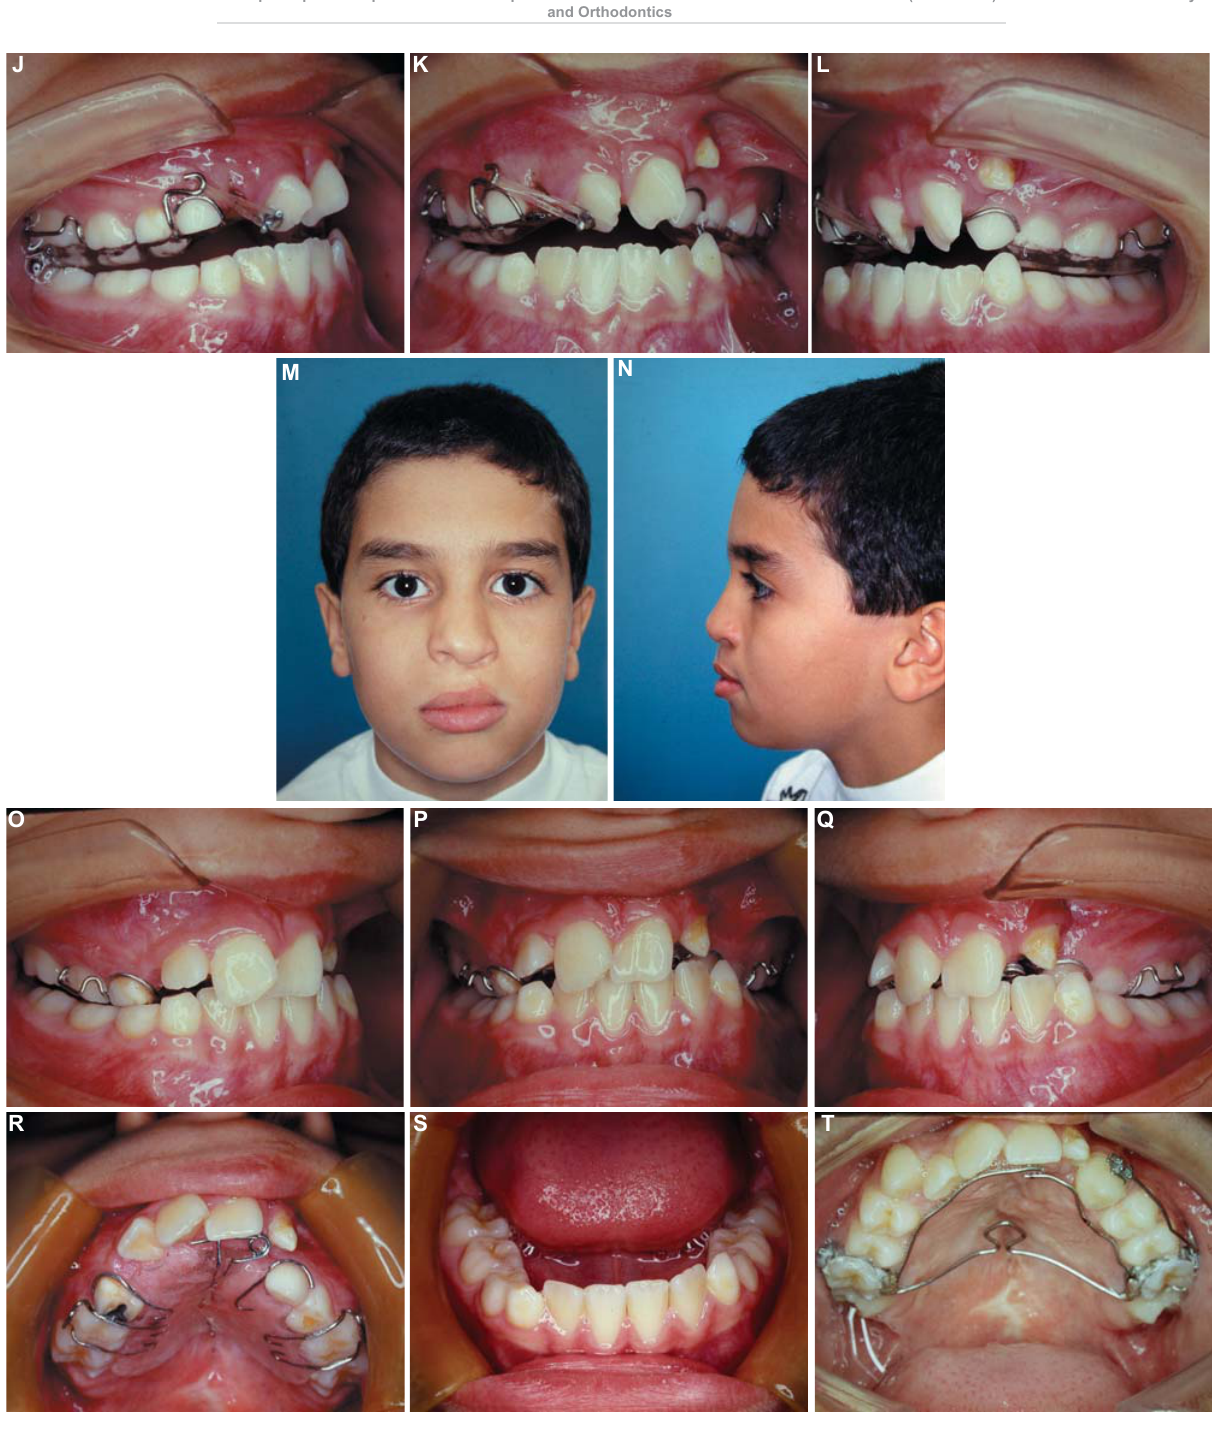
Figure 4- Left unilateral complete cleft lip and palate case. 4A to 4C- before lip and palate repair. 4D to 4F- after lip repair. 4G- after palate repair. 4H to 4S- beginning of orthodontic treatment and dental irruption control. 4T- after rapid maxillary expansion with Haas type expander as described in Figure 3 (parents authorized the publication of these